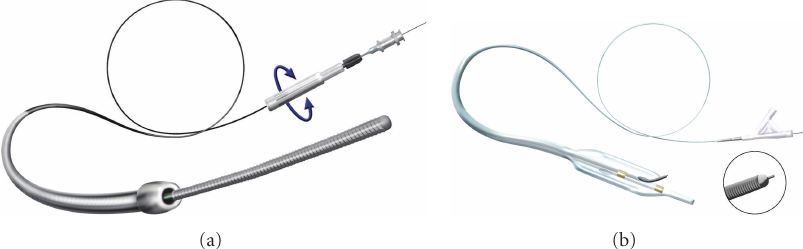
Figure 1: The CrossBoss and Stingray catheters. (a) The CrossBoss catheter is an over-the-wire device with a 1mm rounded tip, a coiled shaft and a moveable proximal torque device that is released under high torque to prevent product damage. (b) The Stingray orienting balloon catheter is an over-the-wire, 10mm long, 2.5 mm wide, flat balloon catheter designed to deploy within the subintimal plane with exit ports on either side of the balloon. Marker bands identify the location of the exit ports. The Stingray guidewire has a 28-degree bend and a distal probe that extends from the tip to aid reentry.